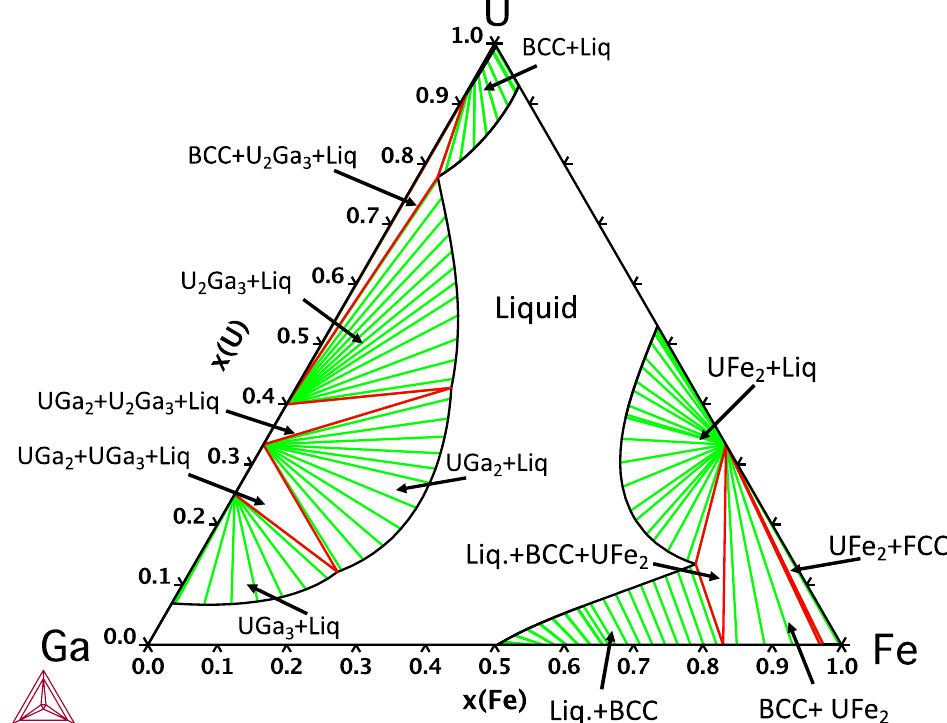
Figure 8. Calculated U-Fe-Ga ternary section at 1000 °C based on the present CALPHAD assessment.